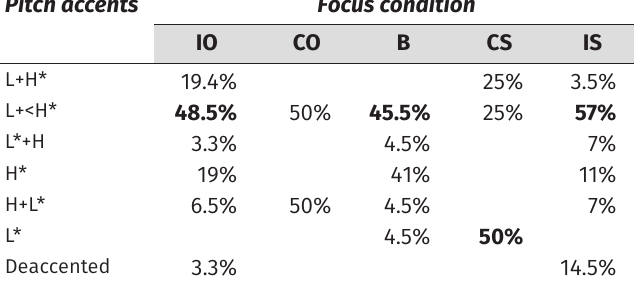
Table 4: Pitch accents produced on non-final objects in five different focus conditions: Informational object focus (IO), contrastive object focus (CO), broad focus (B), contrastive subject focus (CS) and informational subject focus